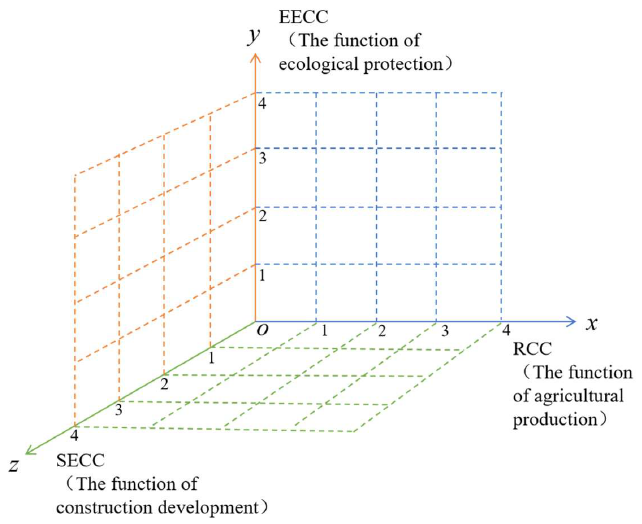
Figure 3. Three-dimensional magic cube evaluation model.